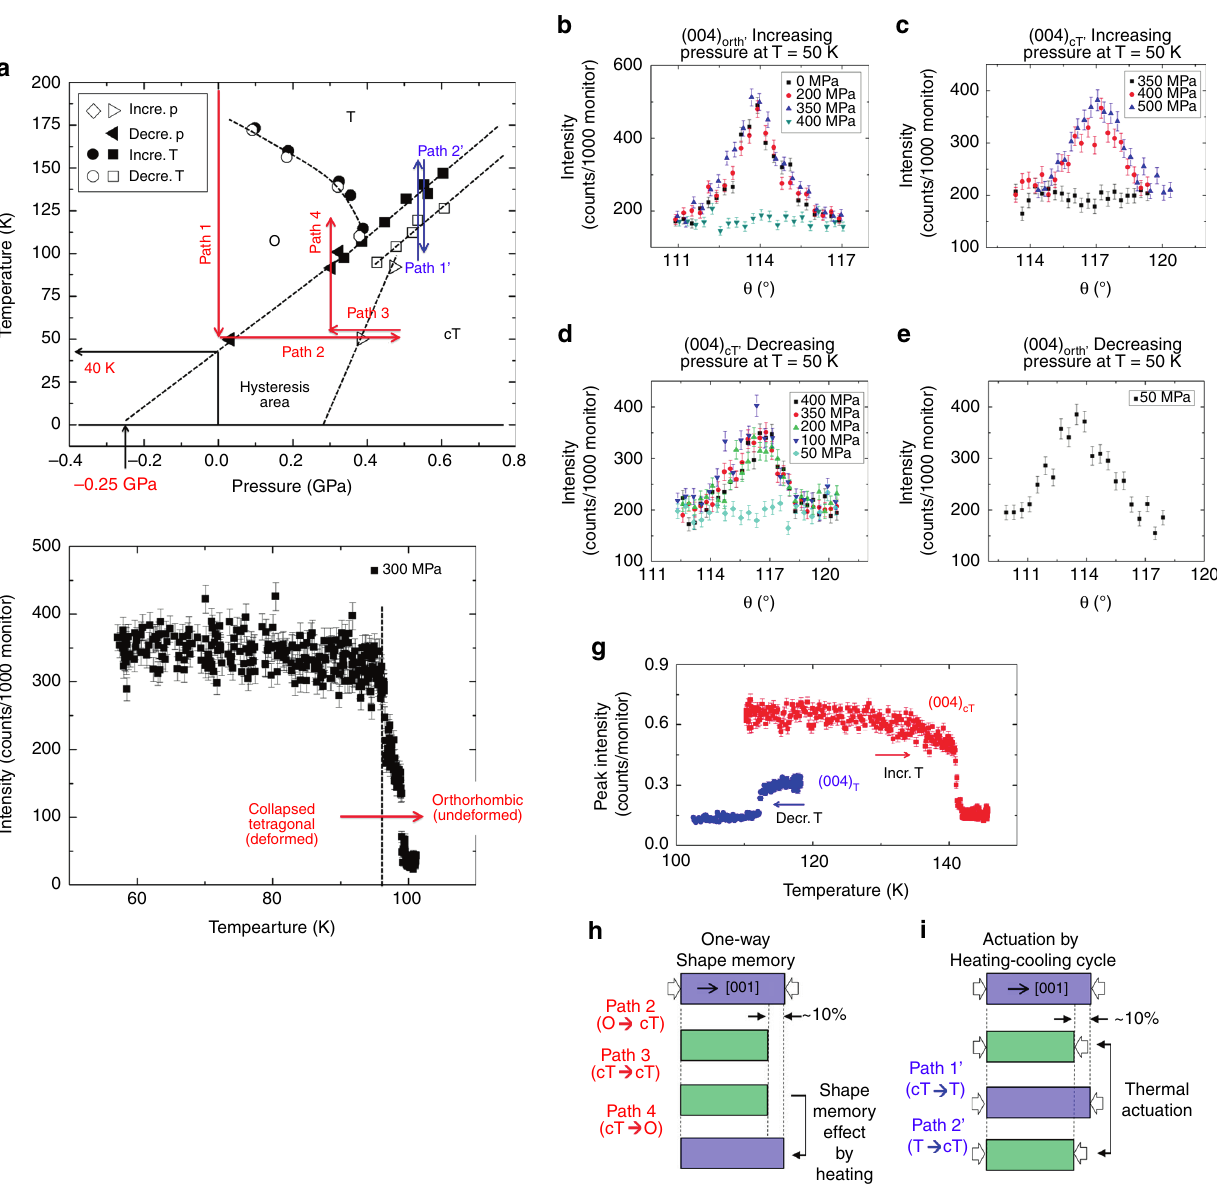
Fig. 4 Linear shape memory effect and thermal actuation in cryogenic environments. a The temperature-pressure phase diagram for CaFe 2 As 2 22 , neutron scattering data of b (004) O plane of orthorhombic phase at T = 50 K with increasing pressure, c (004) cT plane of collapsed tetragonal phase at T = 50 K with increasing pressure, d (004) cT plane of collapsed tetragonal phase at T = 50 K with decreasing pressure, e (004) O plane of orthorhombic phase at T = 50 K and p = 50 MPa, f (004) cT plane of collapsed tetragonal phase at p = 300 MPa with increasing temperature, g (004) planes of tetragonal and collapsed tetragonal phases at p = 470 MPa with increasing and decreasing temperature. Schematic diagrams of h one way linear shape memory effect